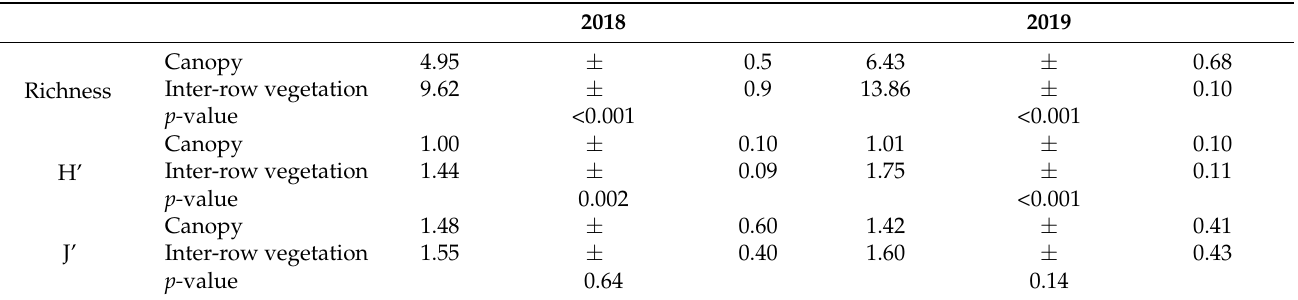
Table 2. Cicadomorpha richness and diversity indices for each stratum sampled per year. Mean